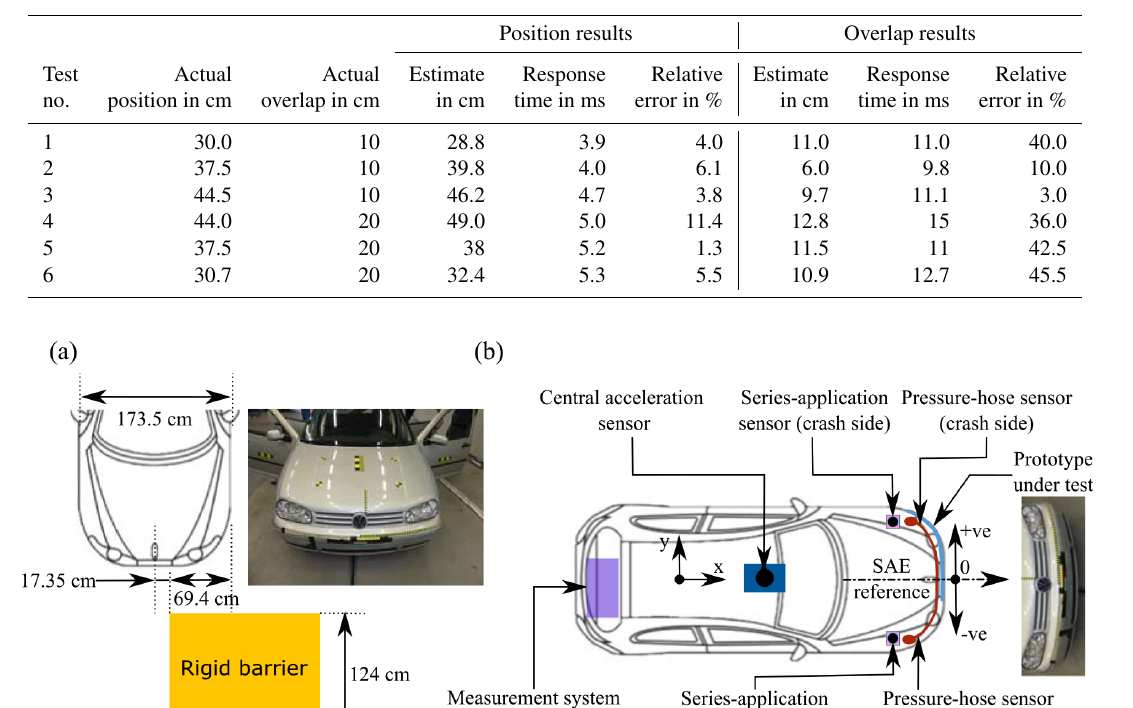
Table 2. Results of pendulum tests.